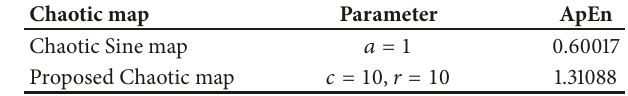
parameters. Hence, the proposed map offers good bifurcation behavior for both the control parameters.